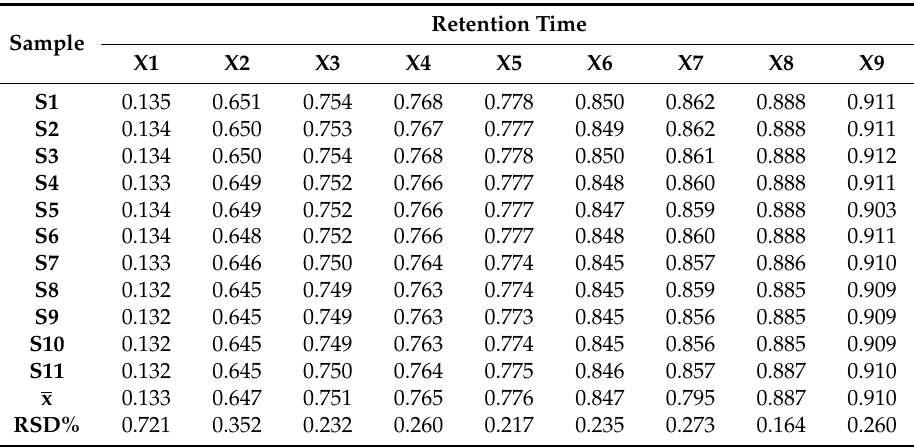
Figure 1. ( a ) HPLC fingerprint; ( b ) the mutual mode; and ( c ) mixed reference substances. Table 1. The relative retention time of 17 common